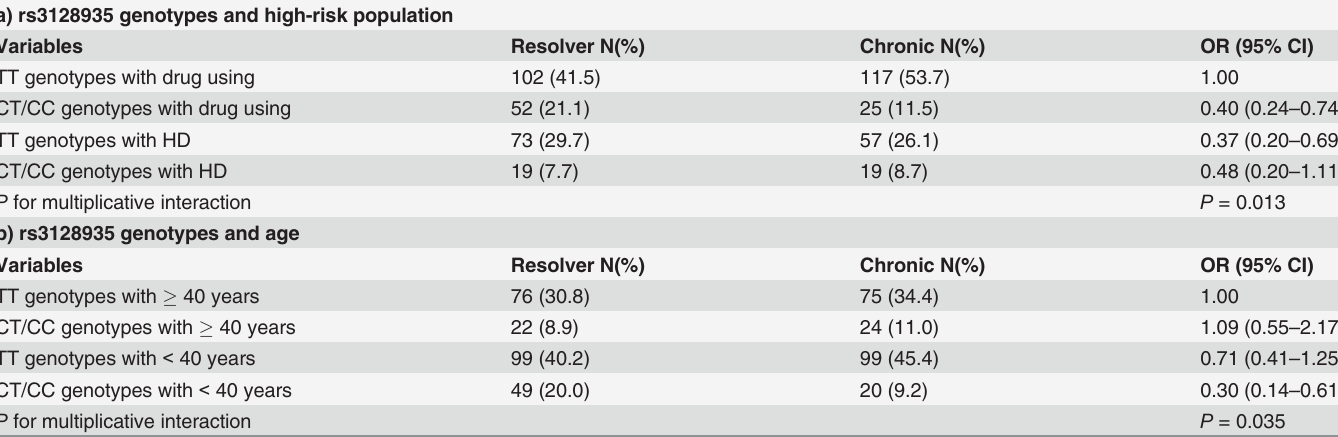
Table 5. Interaction analysis between rs3128935 genotypes and high-risk population or